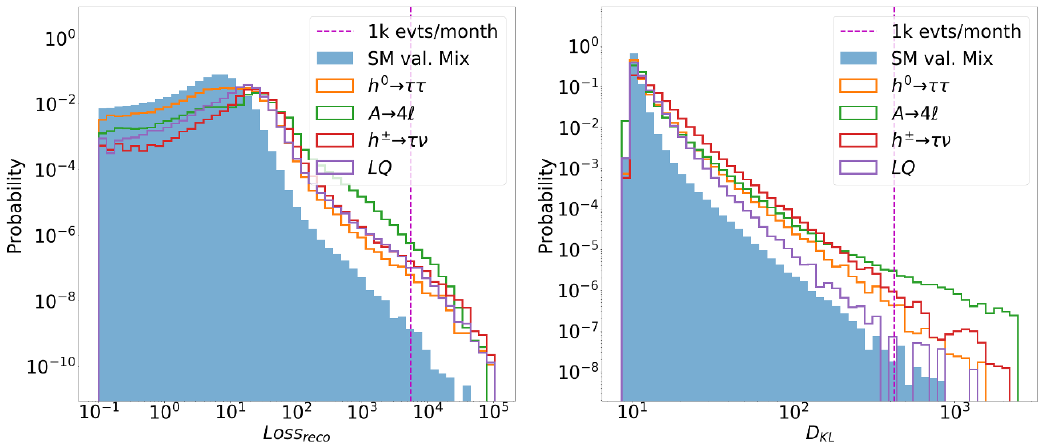
Figure 7 . Distribution of the VAE’s loss components, Loss reco (left) and D KL (right), for the validation dataset. For comparison, the corresponding distribution for the four benchmark BSM models are shown. The vertical line represents a lower threshold such that 5 : 4 (cid:1) 10 (cid:0) 6 of the SM events would be retained, equivalent to (cid:24) 1000 expected SM events per